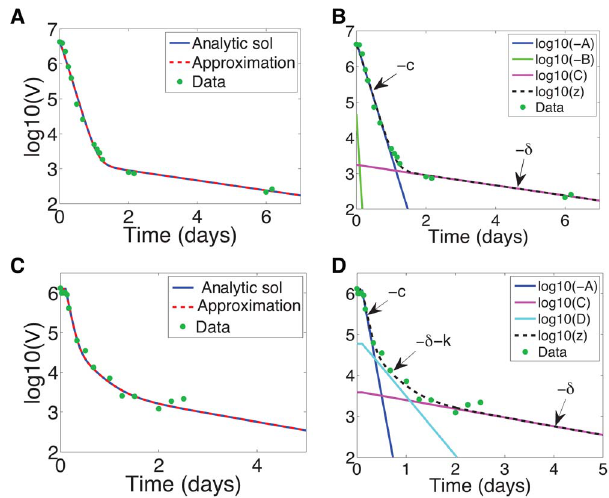
Figure 5. Approximate and analytic solution of the VE model under danoprevir ( 0 v n v 1 ) or telaprevir ( n w 1 ) treatment with patient data. (a,c) Approximate solution (16) compared to the analytic solution (11) for (a) danoprevir or (c) telaprevir treatment. (b,d) Different exponential terms in approximate solution compared with the exact solution, with decay phases indicated, for (b) danoprevir or (d) telaprevir treatment. Danoprevir treatment: data from patient 04-94XD (dosing 200 mg tid) in [25] with associated parameter estimates for VE model z 0 ~ 3 : 63 | 10 6 IU = mL , d ~ 0 : 33 days { 1 , c ~ 7 : 32 days { 1 , k ~ 29 : 08 days { 1 , t 0 ~ 0 days , e 1 ~ 0 , and e 2 ~ 0 : 9996 [unpublished]. Telaprevir treatment: data from patient 6 in [6] with associated parameter estimates z 0 ~ 1 : 27 | 10 6 IU = mL , d ~ 0 : 49 days { 1 , c ~ 15 : 04 days { 1 , k ~ 2 : 82 days { 1 , t